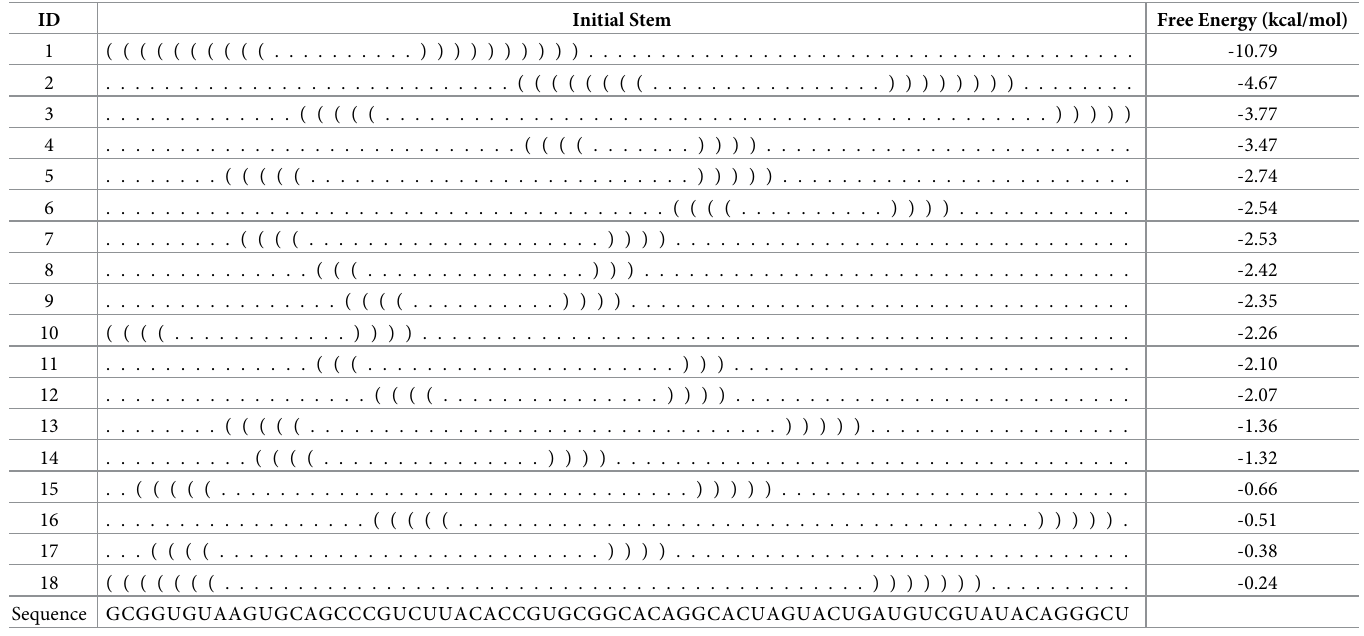
Table 4. The most stable initial stems in SARS-CoV-2 − 1 PRF stimulating pseudoknot reference sequence, ranked based on their free energies. These stems were used as structural constraint for predicting the SARS-CoV-2 − 1 PRF stimulating pseudoknot secondary structure following the hierarchical folding hypothesis. First col- umn provides stem ID (i.e. rank) and the third column lists free energy of the stem. Input sequence is provided in the bottom row.